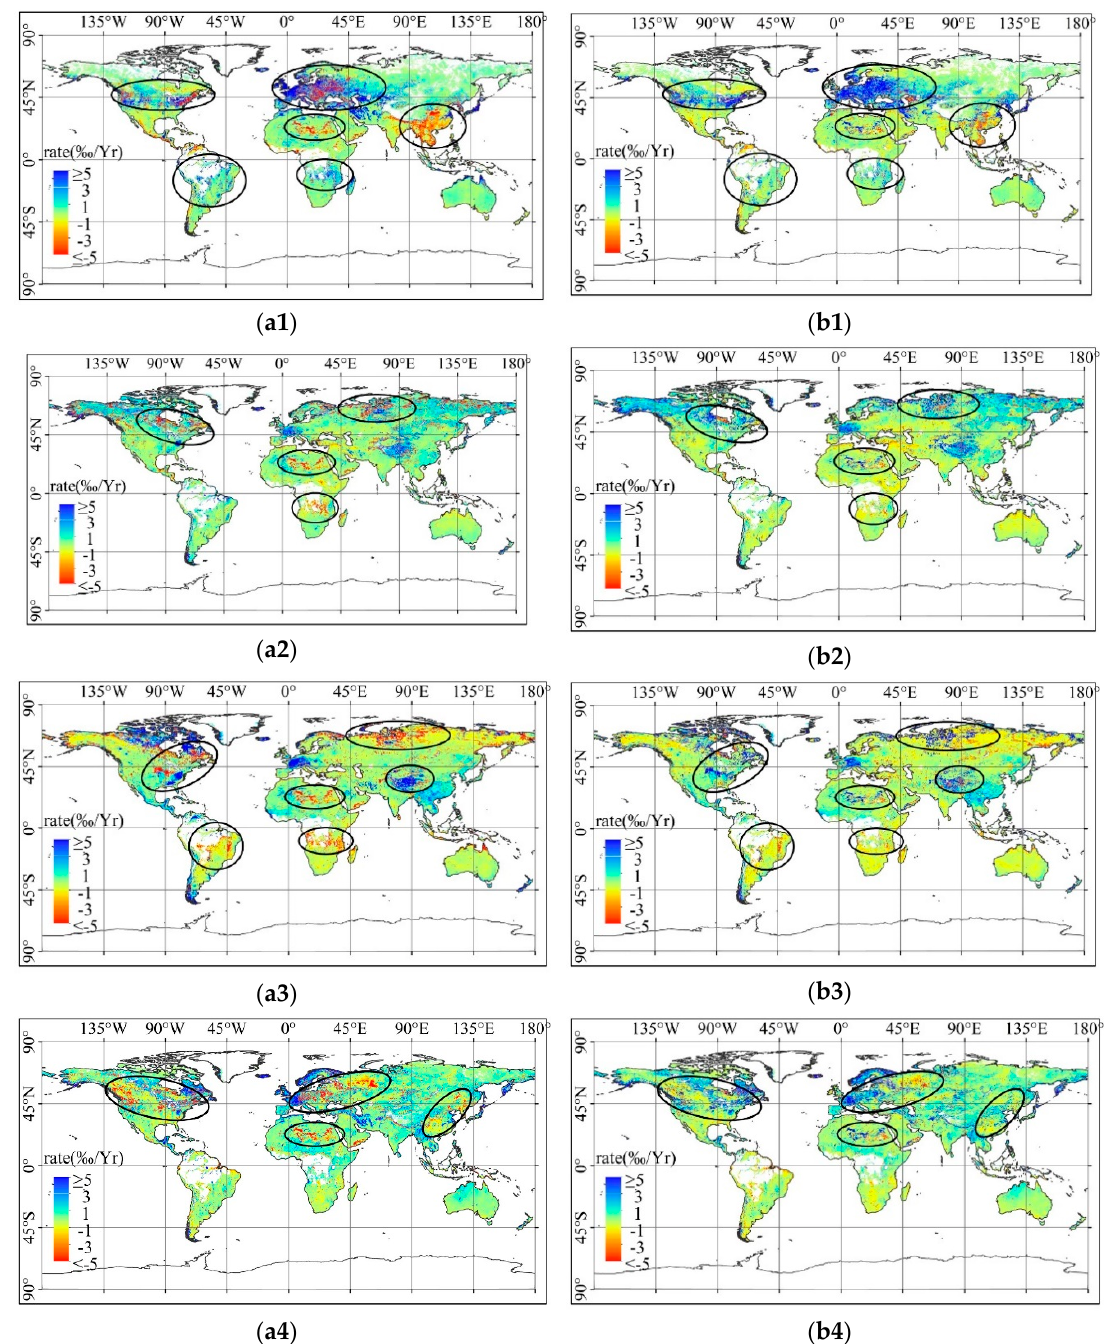
Figure 8. Same as Figure 6, but for the seasonal rates of change. Prefix ( a ) and ( b ) indicate the rates before and after the turning points, respectively; and numbers 1 to 4 stand for the first to the fourth season, respectively.